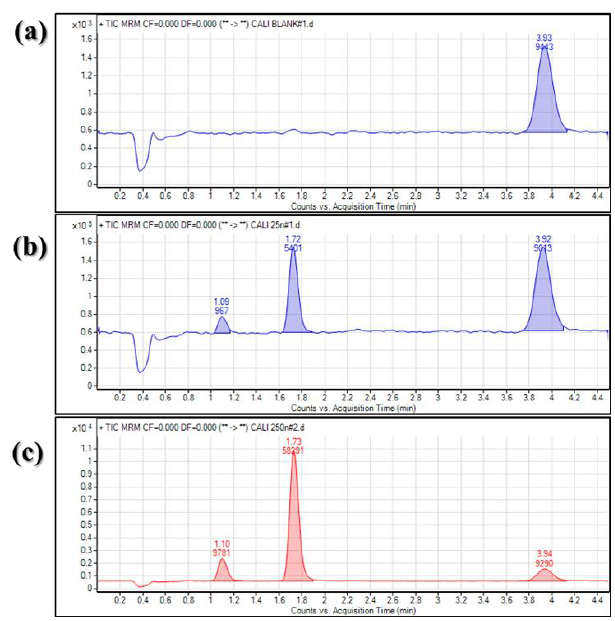
Figure 3. Representative multiple reaction-monitoring (MRM) chromatograms of blank plasma ( a ); blank plasma spiked with internal standard (IS) ( b ); 25 ng/mL plasma sample ( c ); and 250 ng/mL plasma sample.